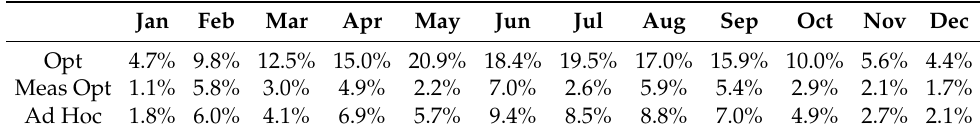
Table 11. Monthly PV self-consumption improvement for a single building with doubled storage size.